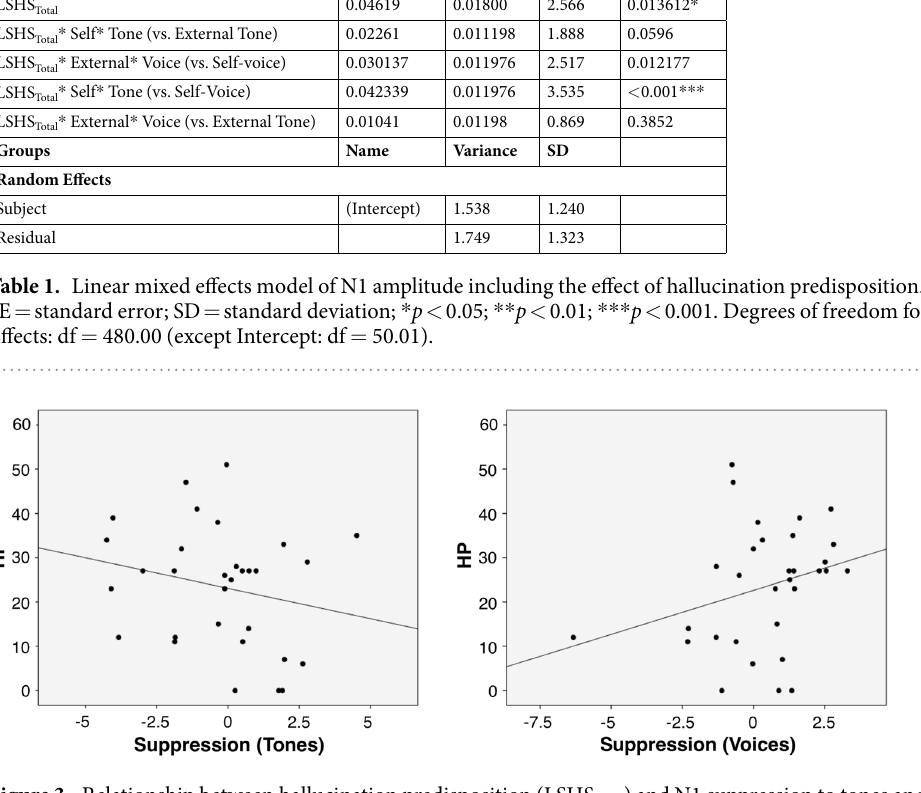
Figure 3. Relationship between hallucination predisposition (LSHS Total ) and N1 suppression to tones and voices. Note. Values represent difference in N1 amplitude between AOC and AMC conditions (negative values indicate less negative N1 in the AMC compared to AOC [AMC<AOC]; positive values indicate more negative N1 in the AMC compared to AOC